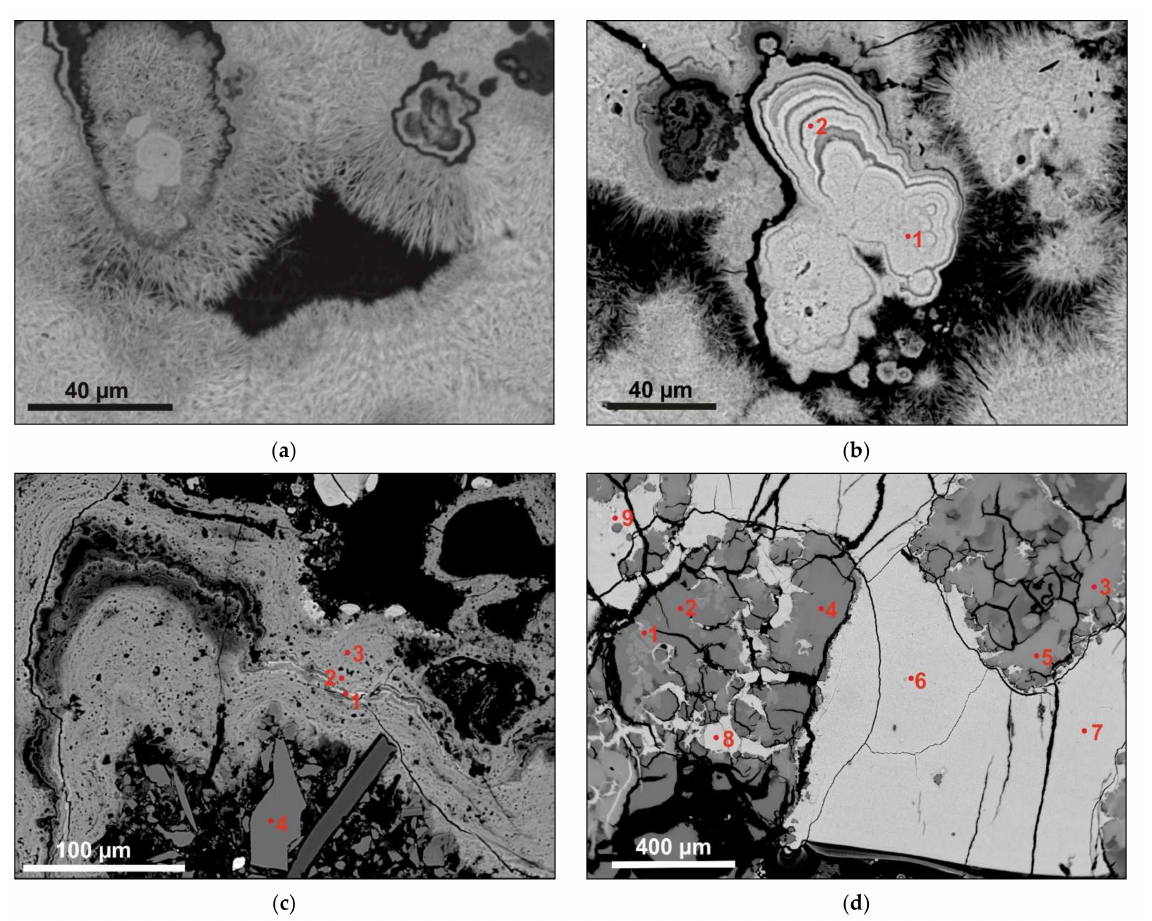
Figure 6. Representative EPMA BSE images of analyzed Mn-Fe crust. Numbers indicate EPMA analytical spots: ( a ) Fine crystalline needles of Mn-oxides in type of todorokite forming highly porous texture (SIO00003U); ( b ) Two generations of thin colloforms of birnessite (1,2) surrounded by coarse generation of todorokite (SIO0000BP); ( c ) Thin lamina of Mn-(Fe) vernadite or asbolane (1) and thick layer of Fe-vernadite (2–3) with admixtures of debris; no. 4 is zoisite-type grain (SIO00003U); ( d ) massive birnessite (6–9) surrounded by patches of crushed Fe-(Mn) rich phyllosilicates in type of celadonite or nontronite (1–5); (SIO0000BP). Various mineral types were distinguished based on calculated stoichiometry, comparison with bulk XRD data and textural features (e.g.,